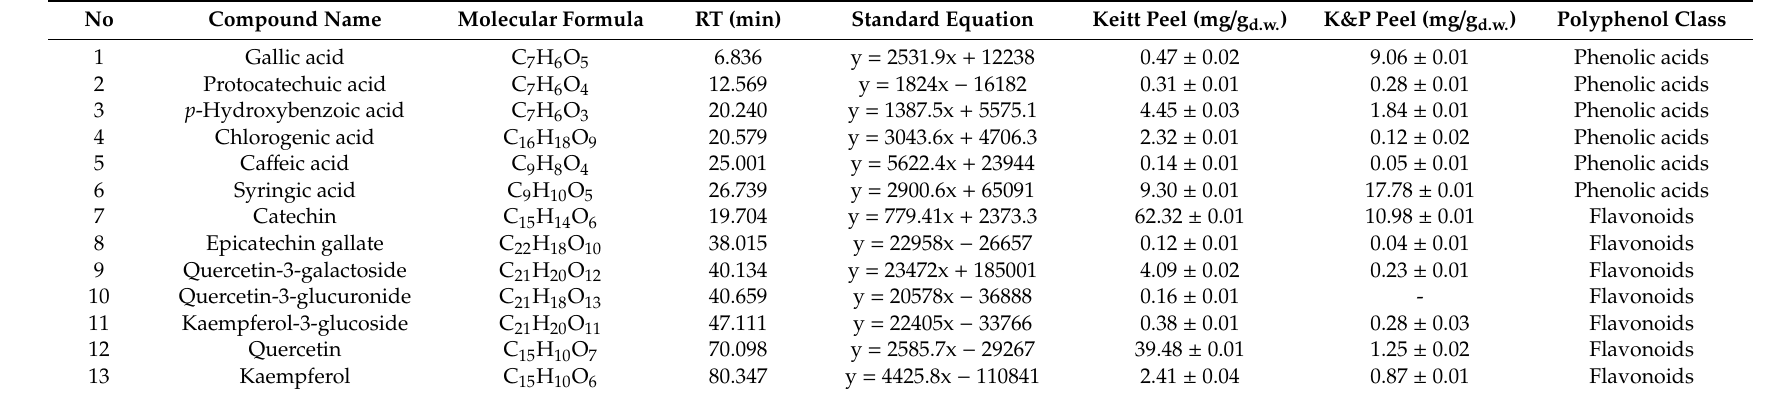
Table 3. Quantification of targeted phenolic compounds by high-performance liquid chromatography (HPLC) in mango